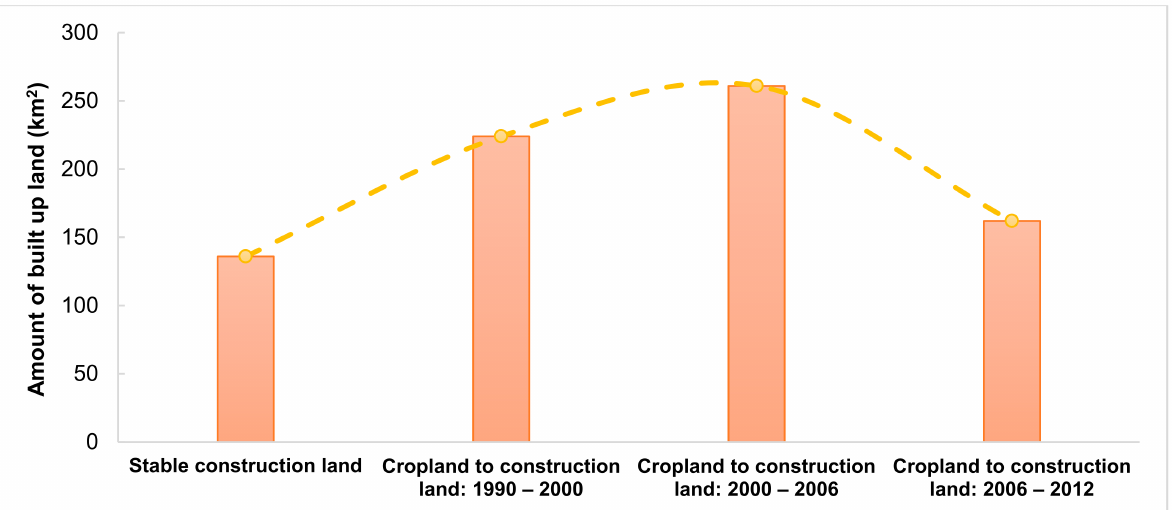
Figure 8. Transition from cropland to construction land in Ho Chi Minh City with data referenced from Kontgis et al.